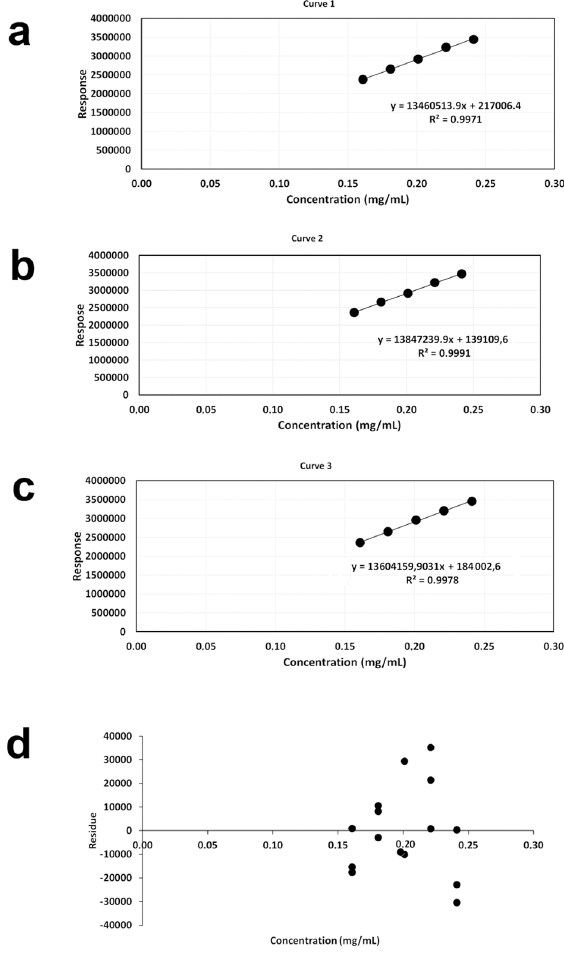
Figure 2. Analytical curves prepared with DEET ICRS diluted in methanol: Curve 1 (AaCurve 2 (b), Curve 3 (c) and Residual analysis of analytical curves